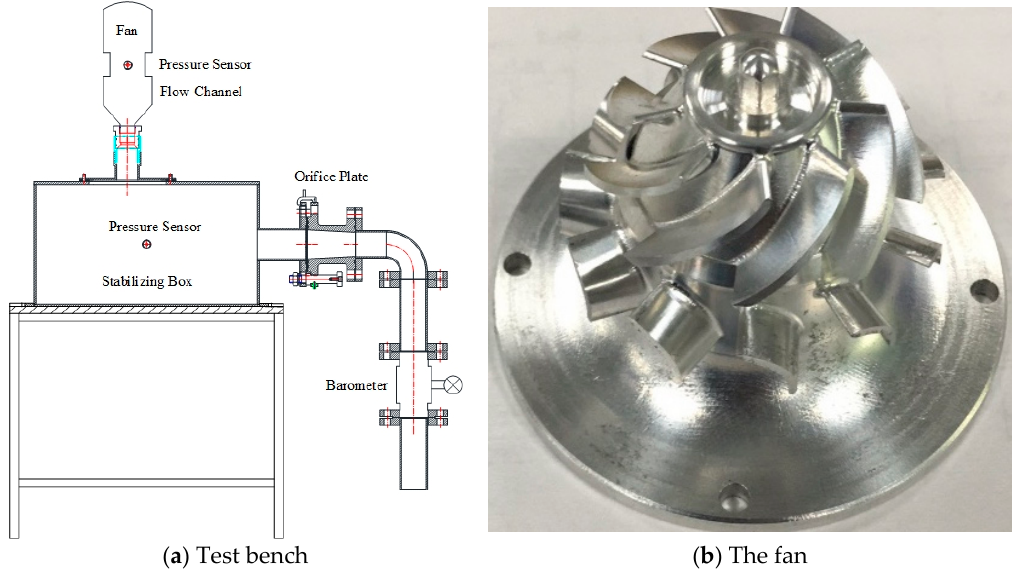
Figure 3. The experimental test bench and the fan. ( a ) Test bench; ( b ) The fan.